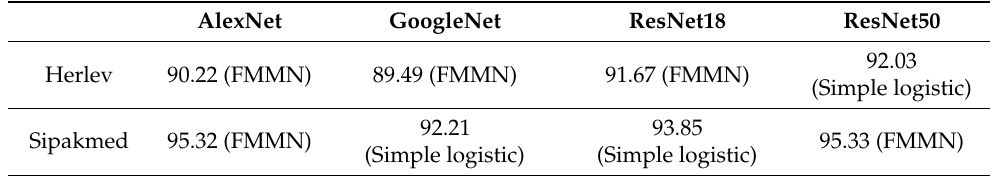
Table 14. Best Classification Accuracy (%) of Two